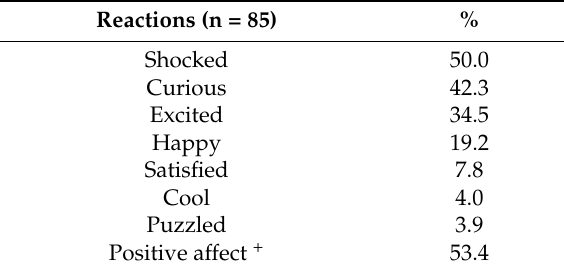
Table 4. Reactions among Non-African respondents who received unexpected African